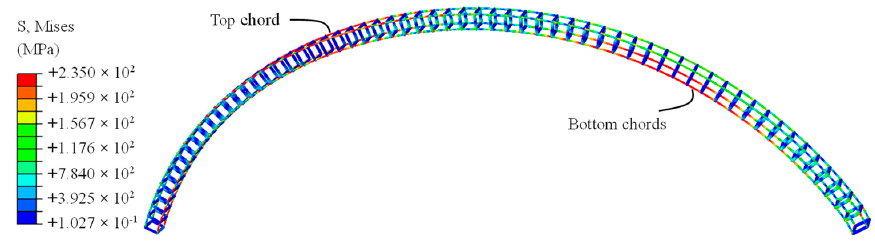
Figure 19. Stress distribution of the typical Vierendeel truss arch under the ultimate HSUVL.